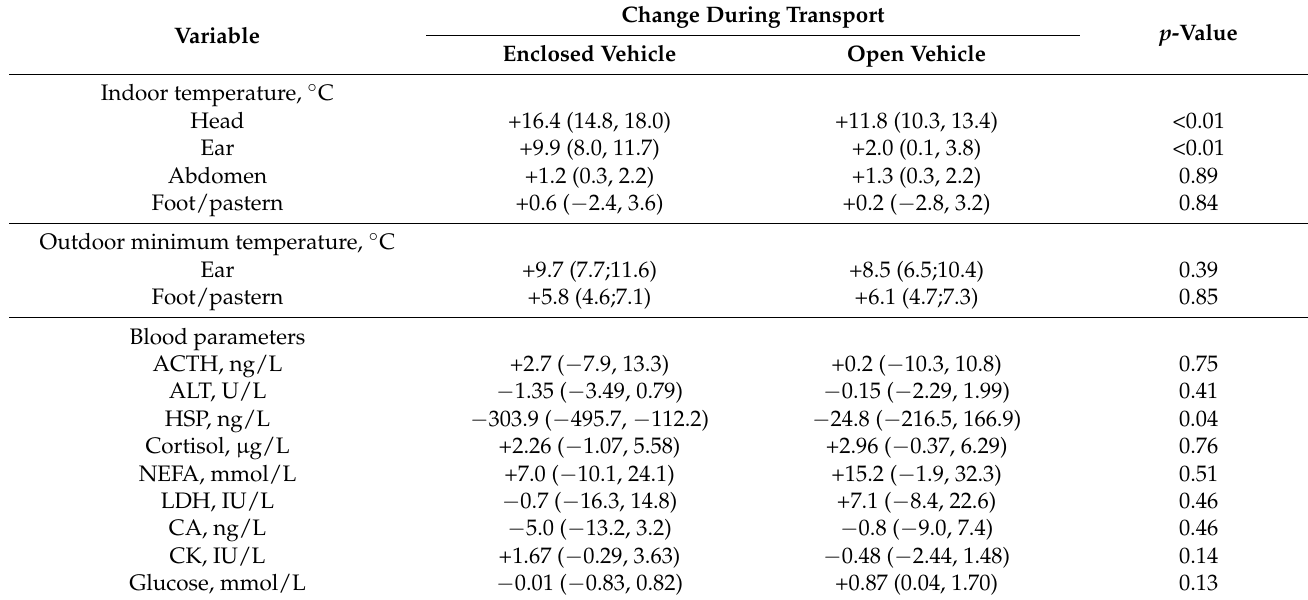
Table 1. Changes in temperatures, infrared temperature images and blood parameters during transport (values at arrival minus values at departure) of sheep (n = 2 × 10) in Experiment 1. Mean changes are adjusted for departure values and are presented with 95% confidence intervals. p -values indicate the statistical significance of treatment effects on the adjusted